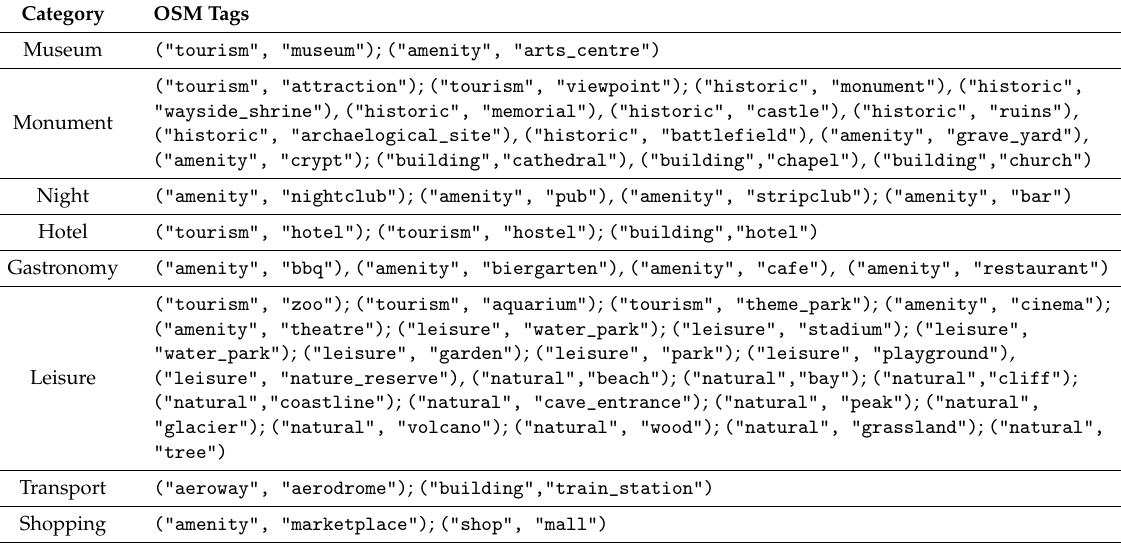
Table 2. Association between O PEN S TREET M AP tags and